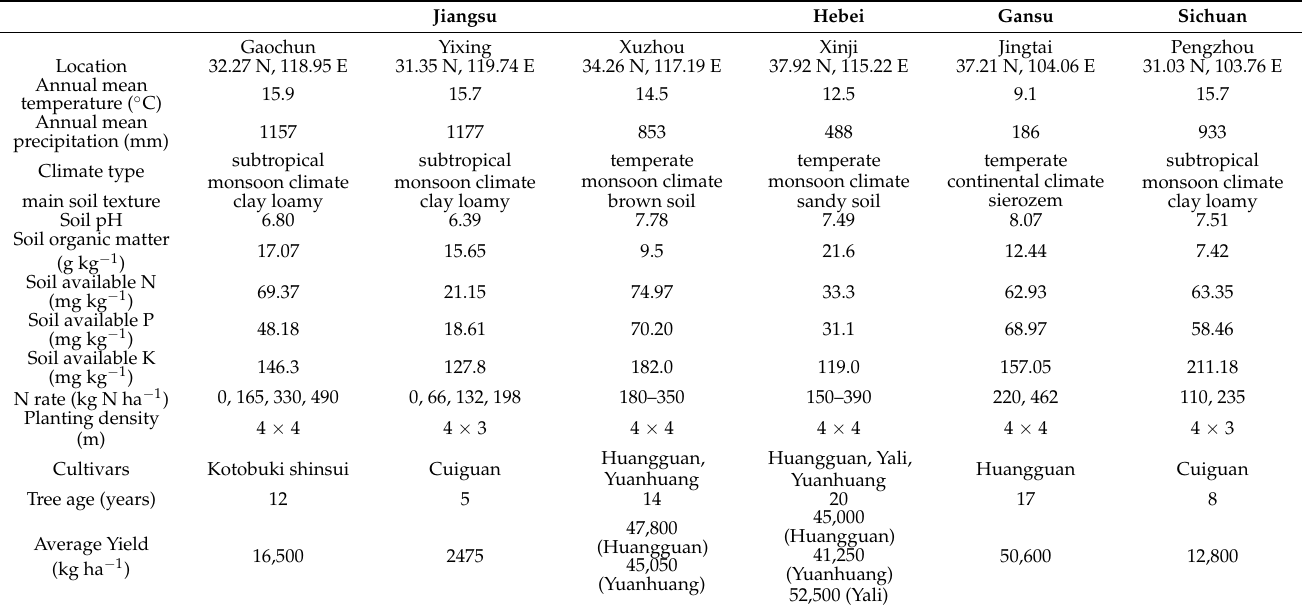
Table 1. Main characteristics of the sampling